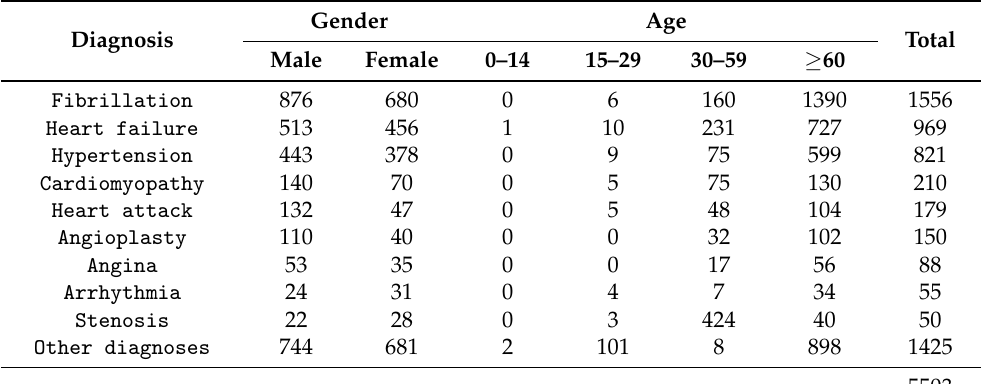
Table 2. Managed patients awaiting medical attention in the cardiology unit. This information presents diagnoses of June 2021